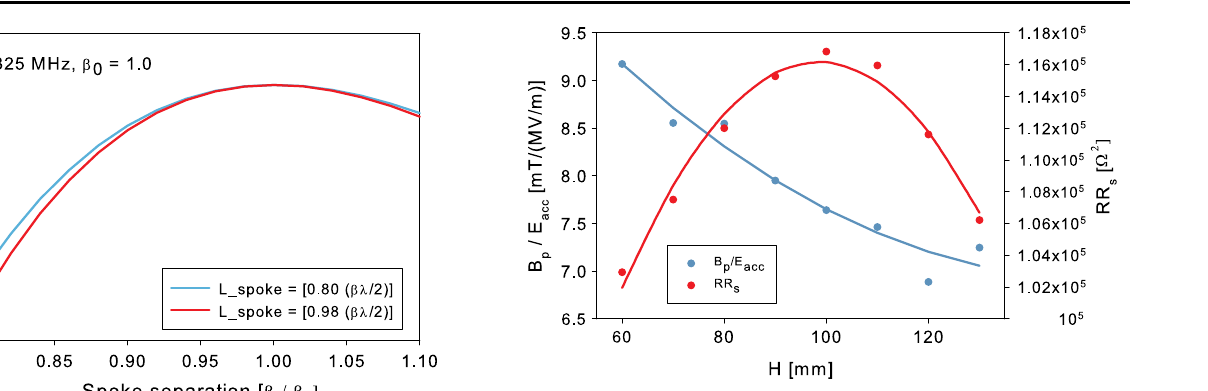
FIG. 26. Velocity acceptance for two different spoke separations.